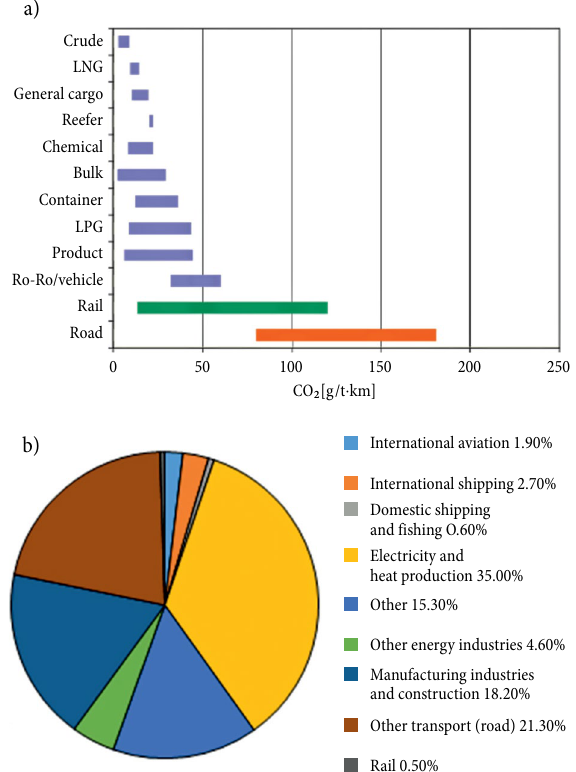
Fig. 1. Specific CO 2 emissions [g/t∙km] (a) and CO 2 emissions [%] from vehicles in the overall global balance